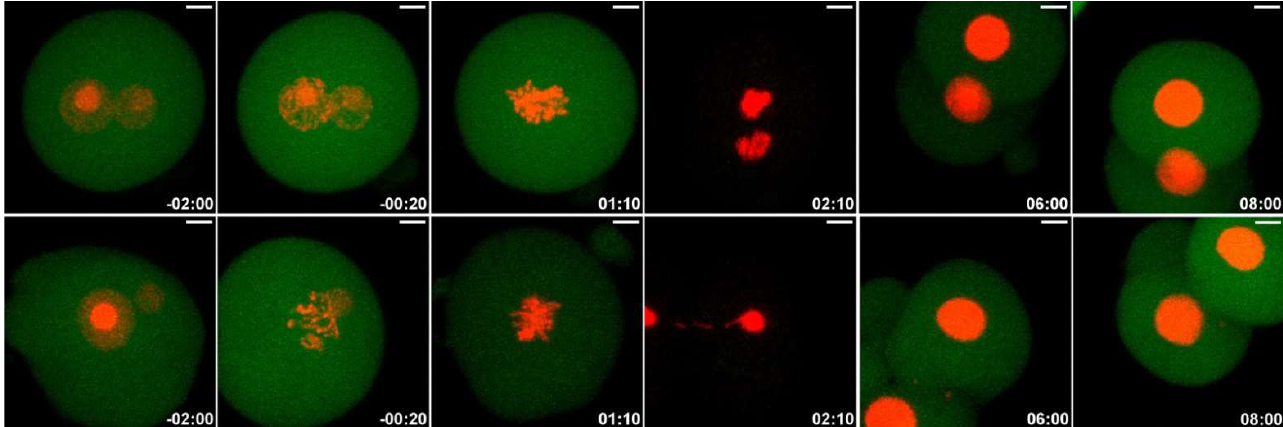
Figure 8. Percentage of the control and NCS-treated one-cell embryos they contain chromosome segregation errors.